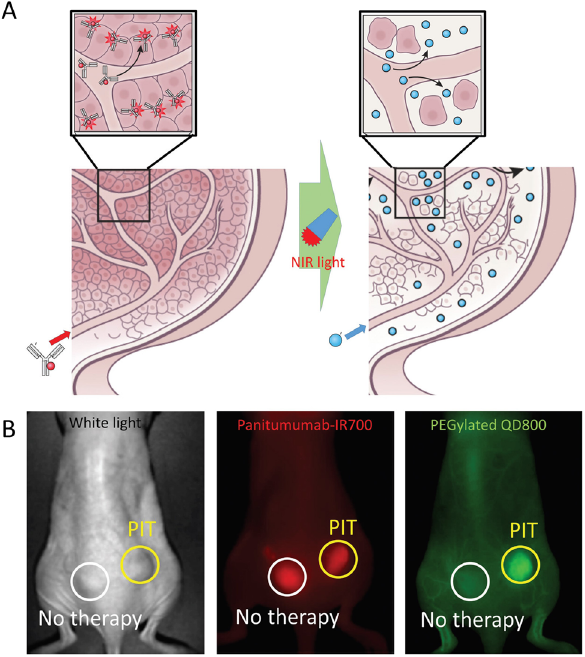
Figure 2: The mechanisms of SUPR effects induced by NIR-PIT. (A)SchemeofSUPReffectinducedbyNIR-PIT.Manyoftheinitialcell killing occurs in the perivascular layer of tumor cells after NIR-PIT, leading to form a potential space around the tumor vasculature. It increases vascular permeability and decreases interstitial pressures. Then, nanodrug delivery to the remaining tumor can be enhanced. Adapted from Ref. [8]. (B) The increases of PEGylated quantum dot 800 into tumor bed 1 h after NIR-PIT were observed compared to control tumors (up to 24-fold). Adapted from Ref.